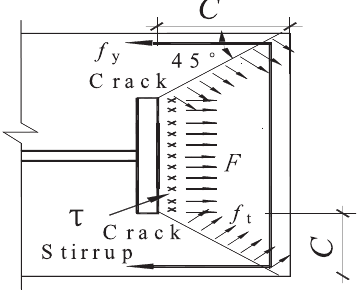
Fig. 2. Computation sketches for Q u